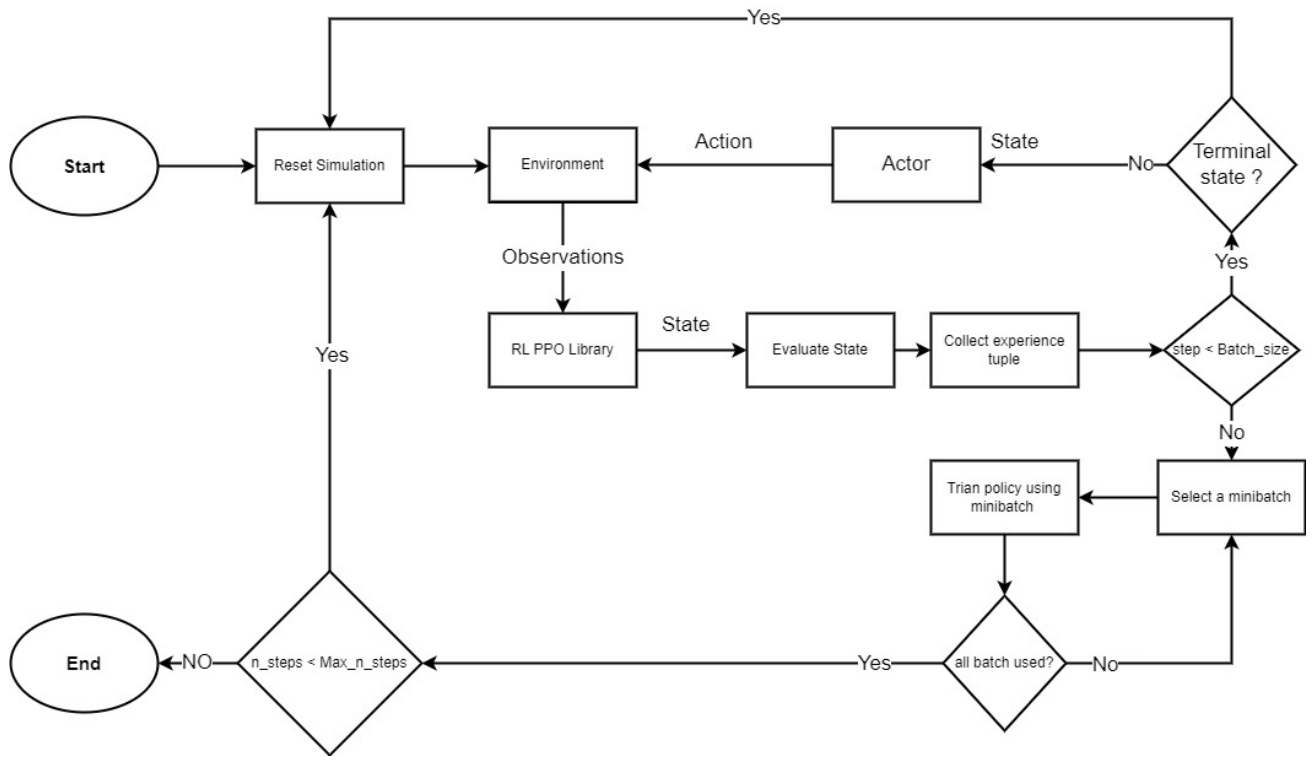
Figure 5. Data flow diagram of the PPO